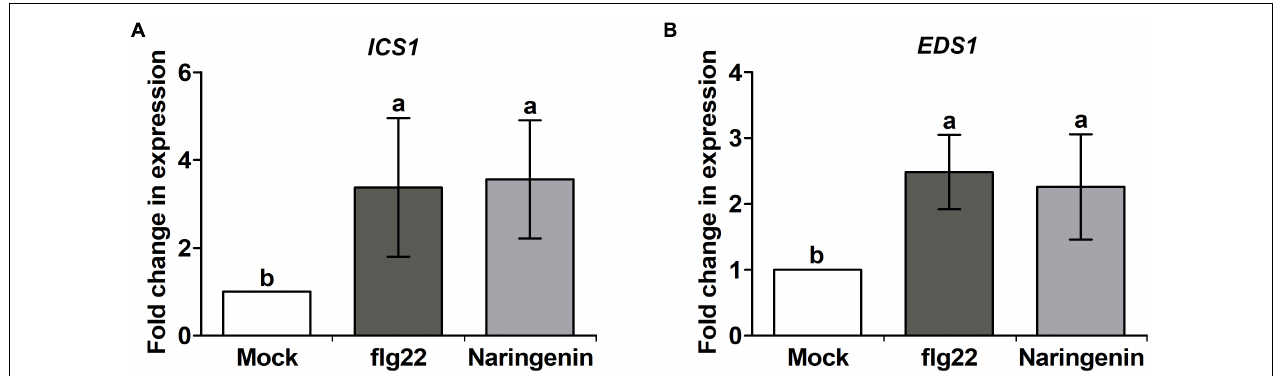
FIGURE 3 | Naringenin increases expression of SA biosynthesis-related genes. Expression of SA biosynthesis-related genes by naringenin. Total RNA was extracted from Col-0 plants treated 0.5 µ M flg22 or 100 µ M naringenin. Samples were collected 24 h post-treatment. Transcript levels of SA biosynthesis-related genes are increased in Col-0 plants. ICS1 (A) and EDS1 (B) transcript levels were measured by qPCR using specific primers. Tubulin was used as an internal control. Error bars indicate SD. Different letters above bars indicate statistically significant differences between samples, according to Tukey’s honestly significant difference test ( P < 0.05). The experiment was repeated three times with similar